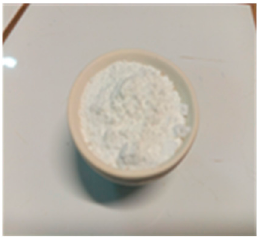
Figure 1. Appearance of γ